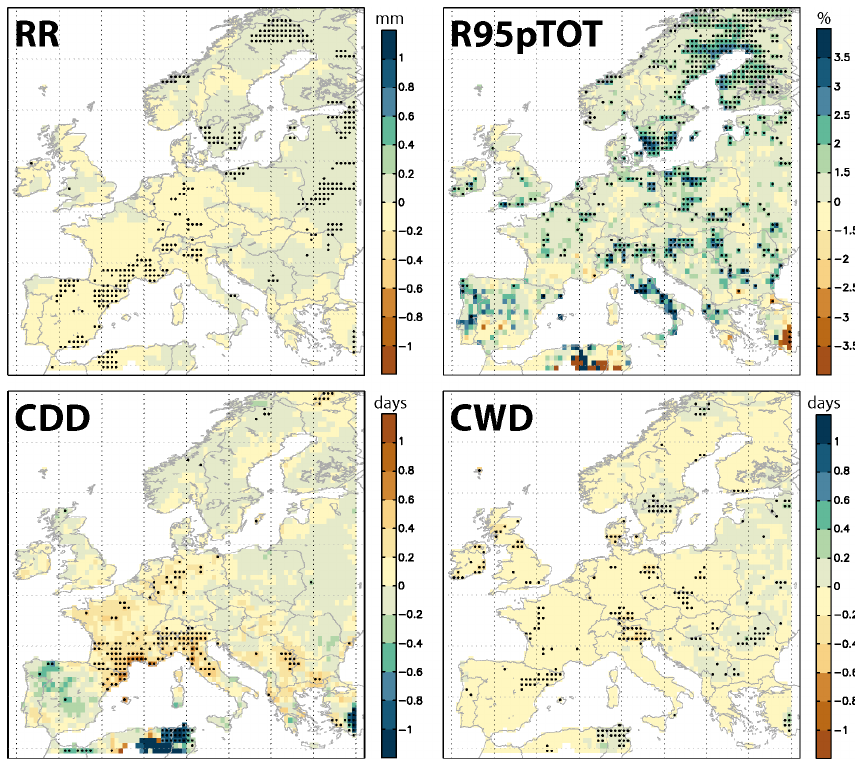
Fig. 6. As in Fig. 2, but for summer. Table 4. As Table 2, but for summer. Only significant values are shown ( ∗∗ p value < 0.01, ∗ p value <